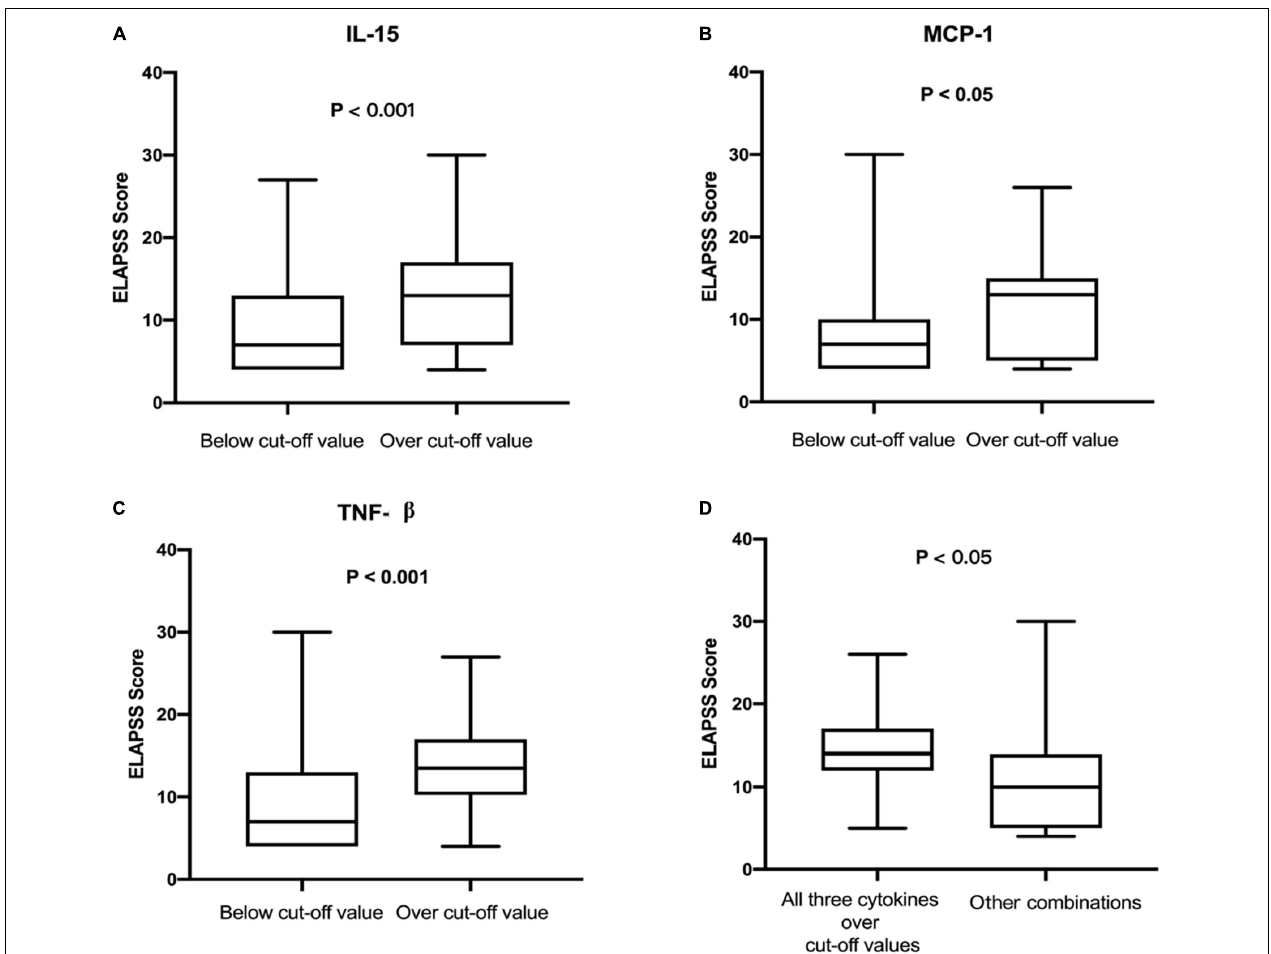
FIGURE 5 | (A) The ELAPSS score between patients with the level of IL-15 below and over the cut-off value. (B) The ELAPSS score between patients with the level of MCP-1 below and over the cut-off value. (C) The ELAPSS score between patients with the level of TNF- β below and over the cut-off value. (D) The ELAPSS score of patients with high level of IL-15, MCP-1, and TNF- β was significantly higher than other combinations of these 3 cytokines. IL-15, interleukin 15; MCP-1, monocyte chemoattractant protein-1; TNF- β , tumor necrosis factors- β .